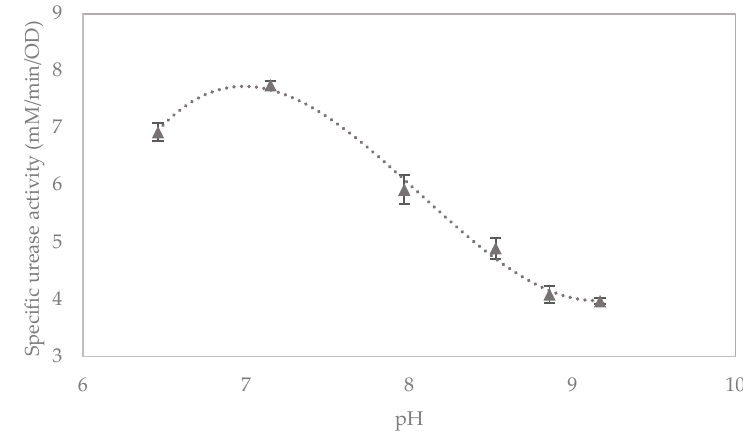
Figure 4. E ff ect of pH on specific urease activity in liquid broth cultures, with error bars showing Figure 6. Effect of pH on specific urease activity in liquid broth cultures. standard errors of the